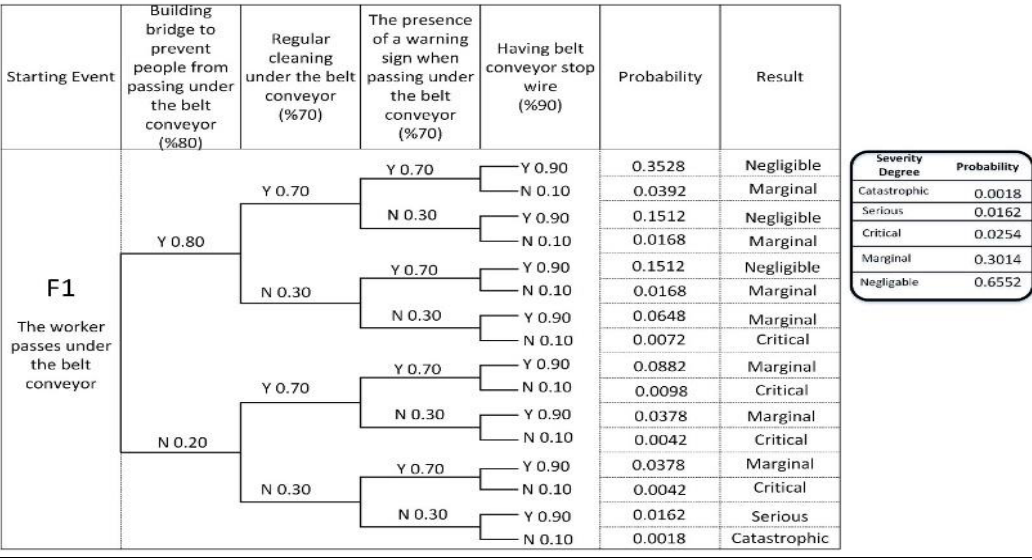
Figure 5: Event tree analysis diagram of F1.